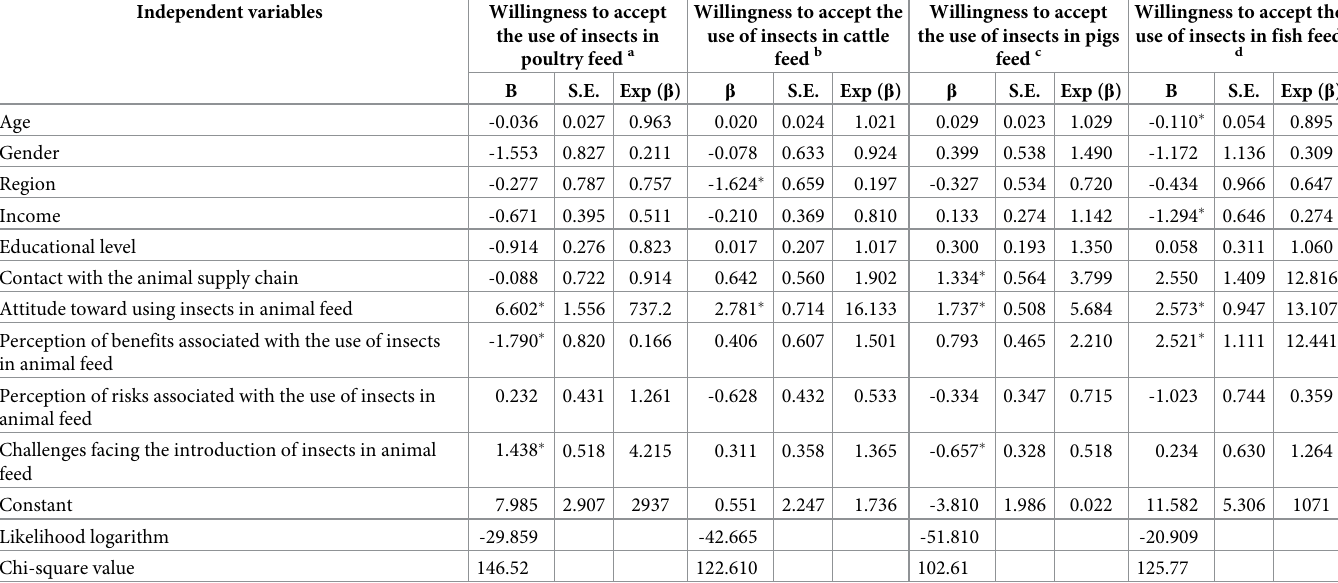
Table 2. Logistic regression models of the willingness to accept the use of insects in feed for poultry, cattle, pigs and fish supply